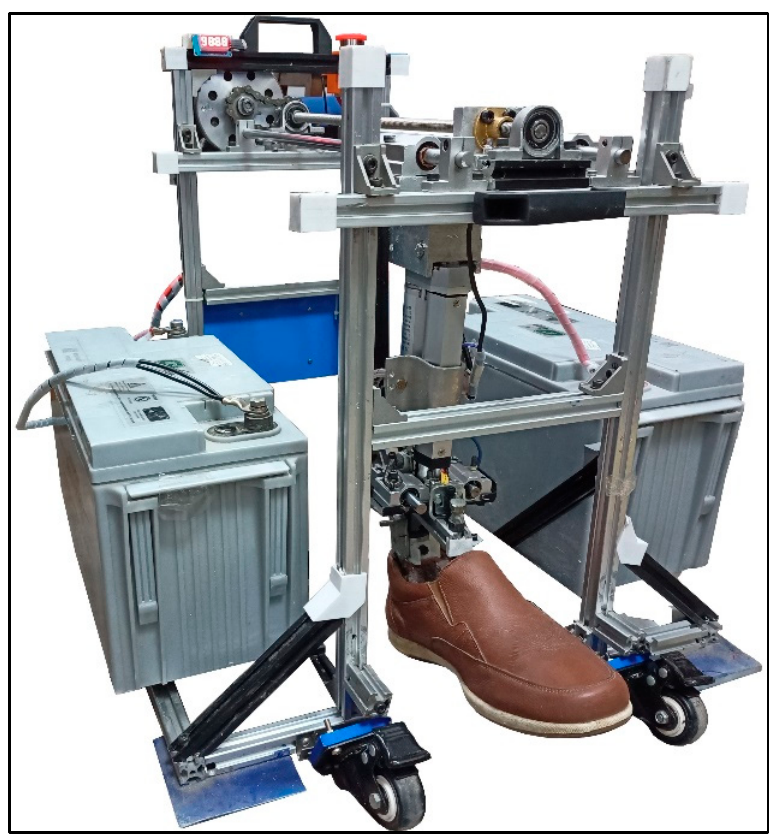
Figure 4. Whole-shoe biofidelic and portable slip tester used for experiments.